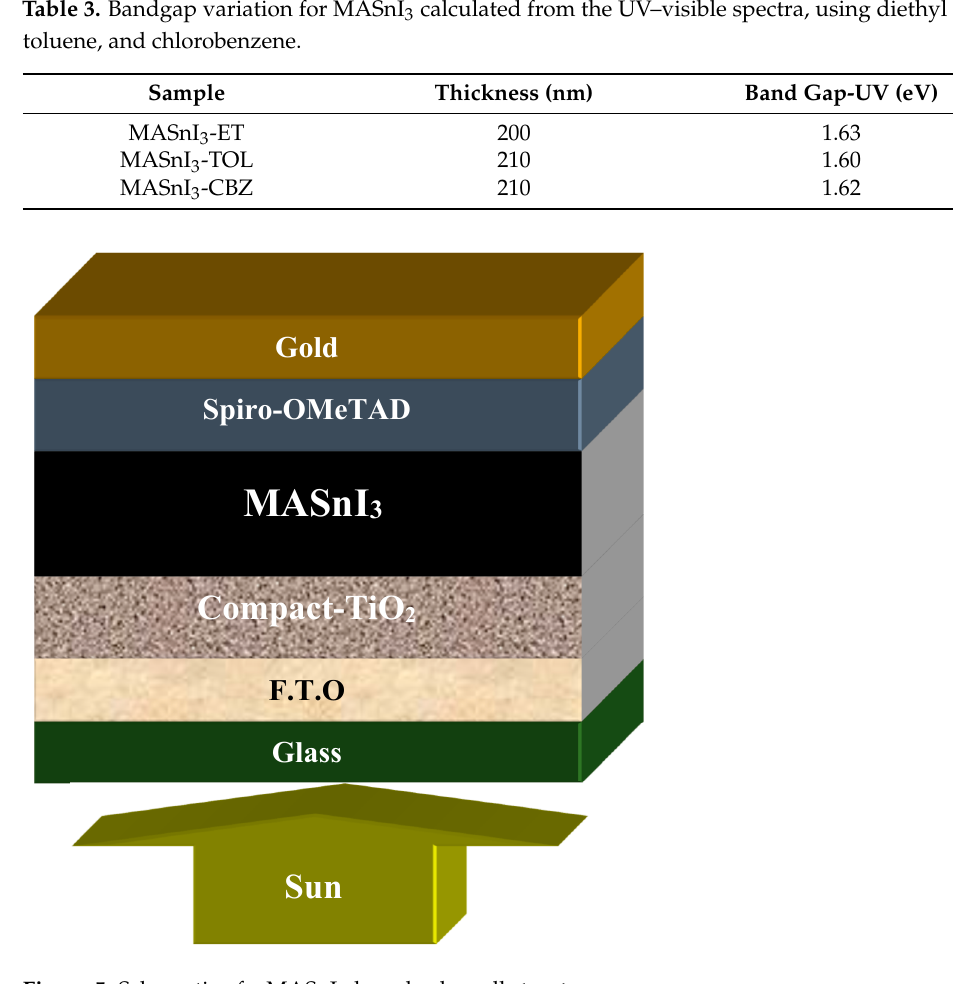
3 -based solar cell